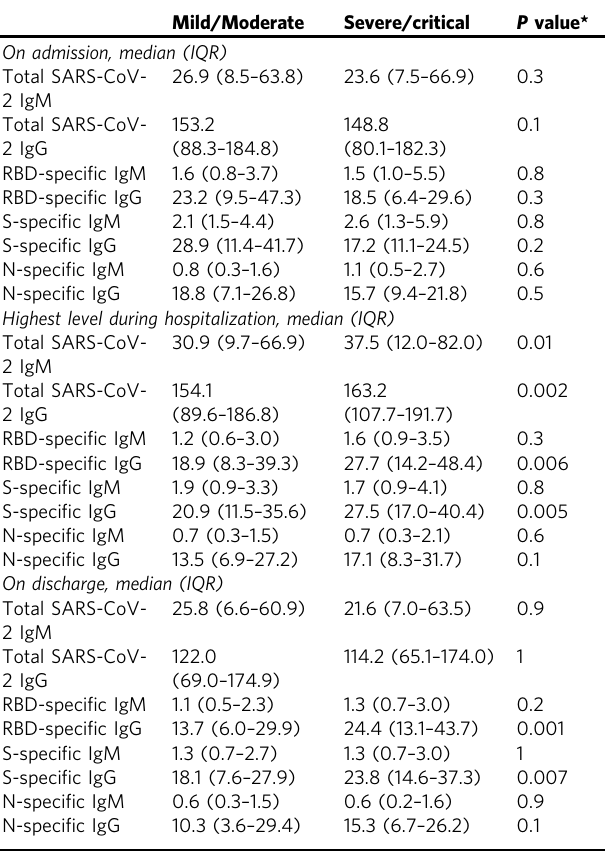
Table 1 SARS-COV-2-speci fi c antibody levels in COVID-19 patients with different severity.